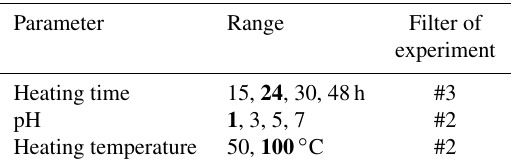
Table 3. Investigated method parameters and used PTFE filters from 1,3,5-TMB oxidation for method development.